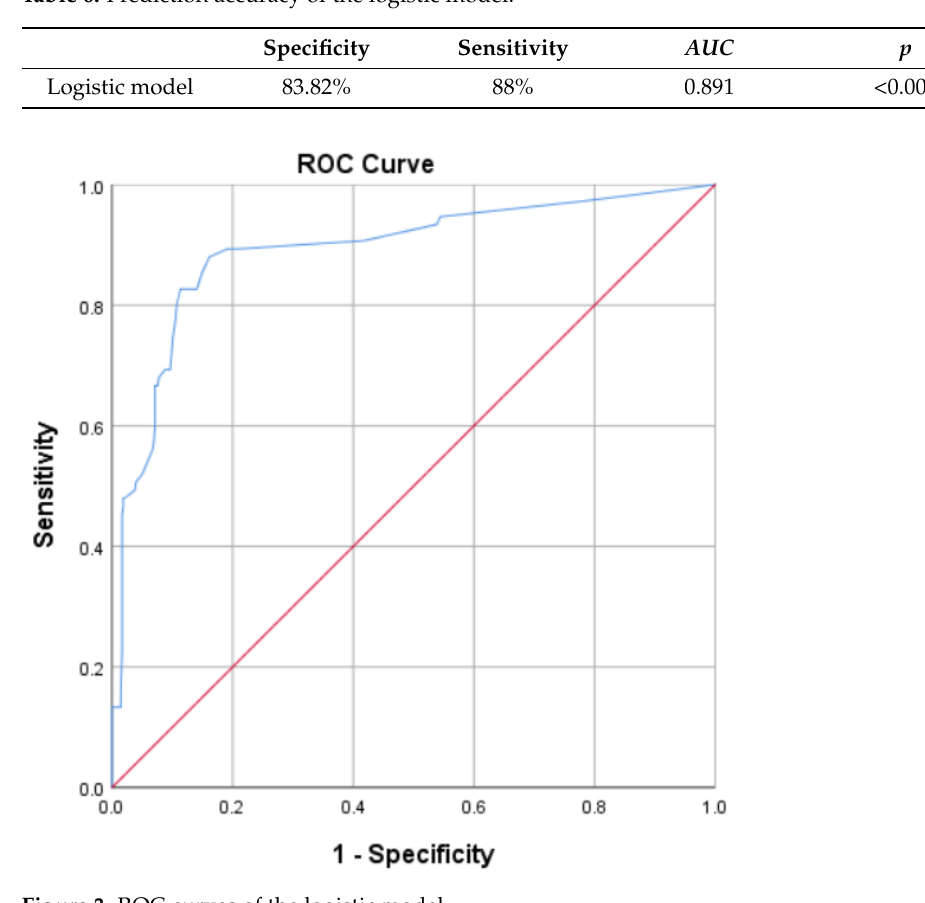
Figure 3. ROC curves of the logistic model.